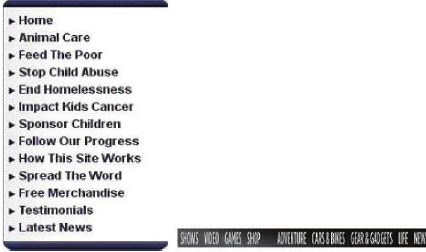
Figure 5: Examples of menu objects.